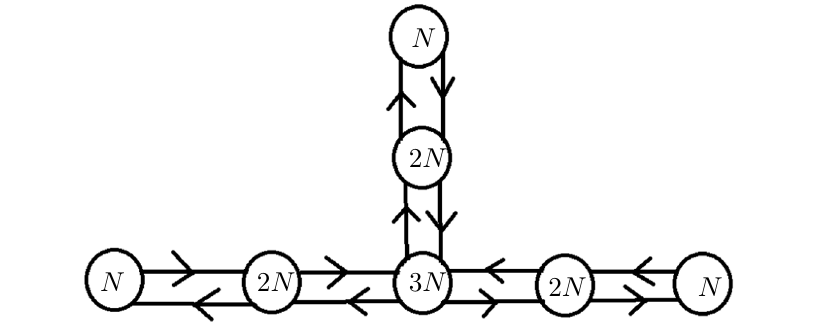
Figure 6 . b E 6 quiver diagram with gauge group U(2 N ) 3 (cid:2) U( N ) 3 (cid:2) U(3 N